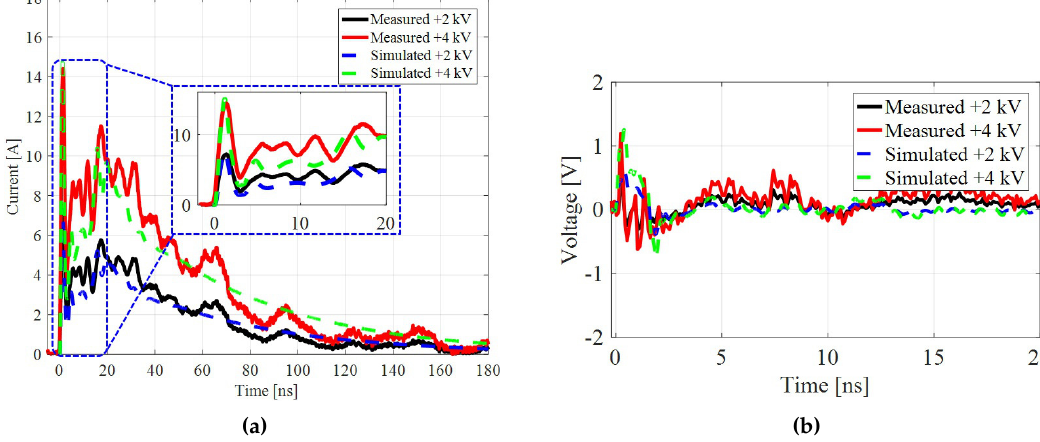
Figure 4. Measurement vs. simulation results: ( a ) comparison of measured and simulated ESD current waveforms; and ( b ) comparison of measured and full-wave EM simulation results of induced voltages for µ -strip line test